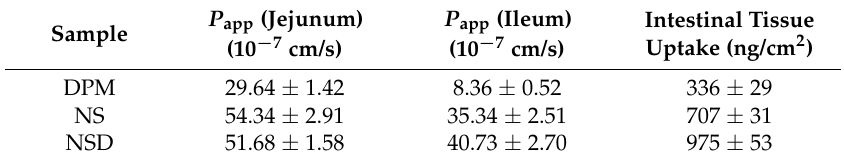
Table 4. P app (jejunum and ileum segments) and intestinal tissue uptake (jejunal segment) values of DPM, NS, and NSD in everted gut sac. Data are expressed as the mean ± standard deviation ( n =